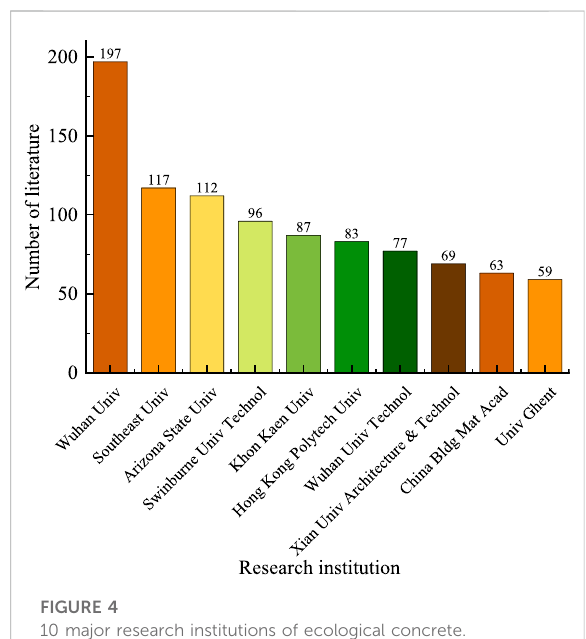
FIGURE 4 10 major research institutions of ecological